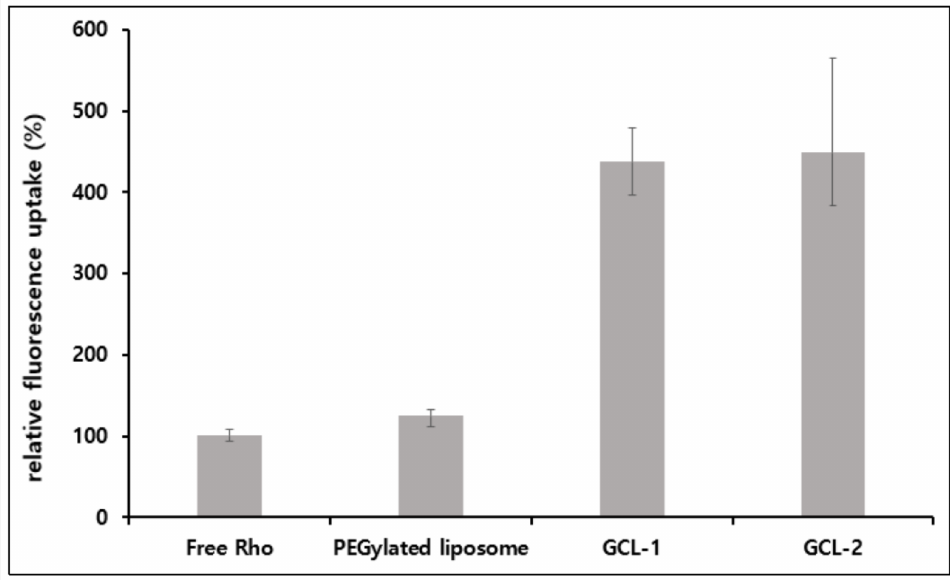
Figure 7. Relative fluorescence uptake among free rhodamine B and liposome formulations.